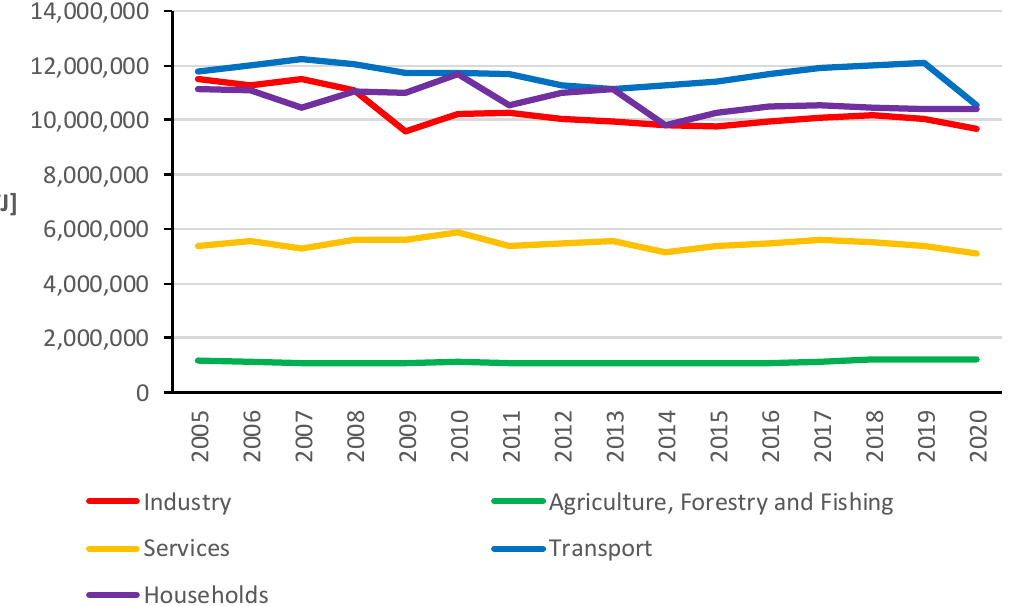
Figure 2. Final energy consumption by sector and area in EU countries from 2005 to 2020.